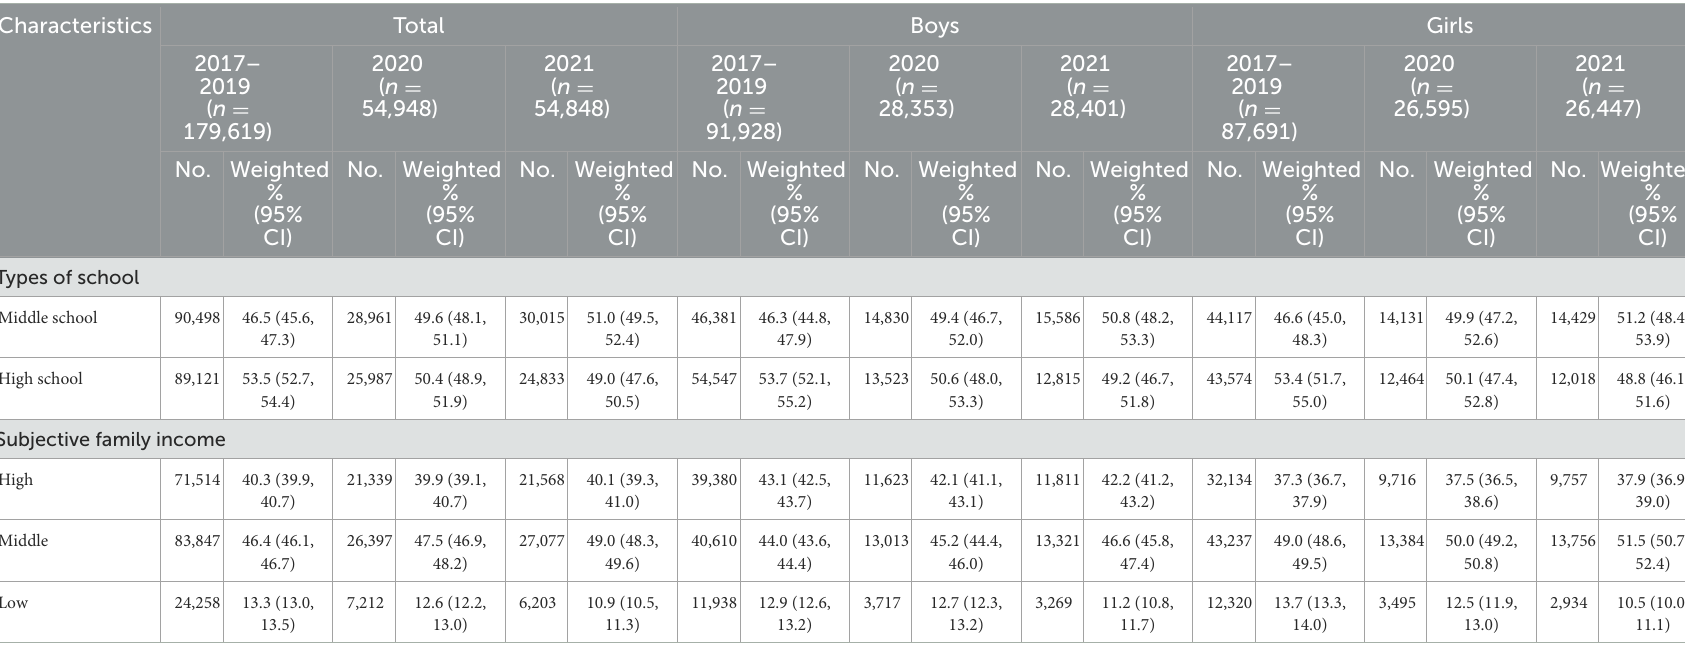
TABLE 1 Sociodemographic characteristics in the KYRBS 2017–2019, 2020, and 2021 samples by sex stratification ( n = 289,415).